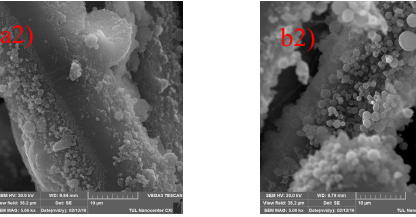
Figure 5. Scanning electron microscope images of PTFE layers (P1: a1 , a2 ; P2: b1 , b2 ; P3: c1 , c2 ; and P4: d1 , d2 ).